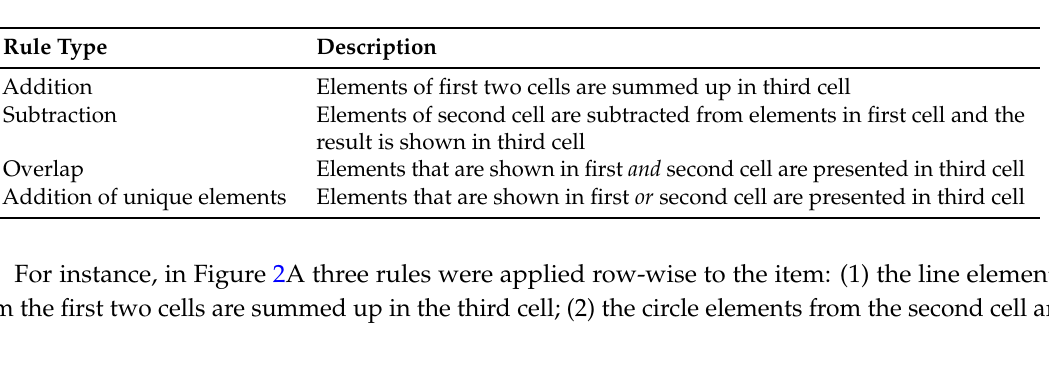
Table 1. Rule types and